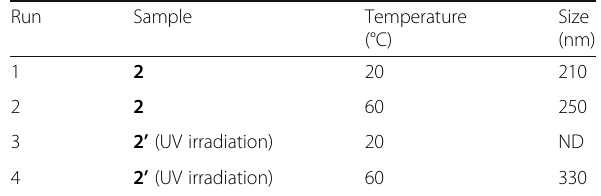
Table 2 DLS data of 2 and UV irradiated